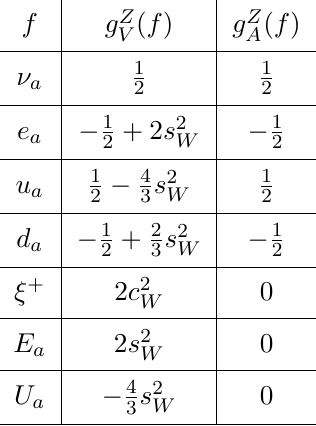
Table 3 . The couplings of Z with